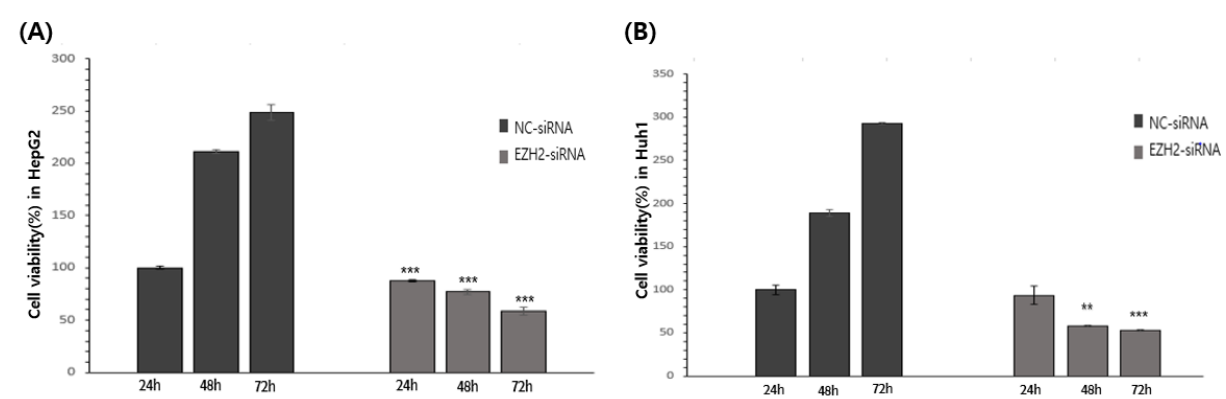
Figure 5. siRNA knockdown of EZH2 and growth of HCC cells. ( A ) Detection of cell viability after transfection in HepG2. ( B ) Detection of cell viability after transfection in Huh1. ** p < 0.01, and *** p < 0.001 by Student’s t -test.